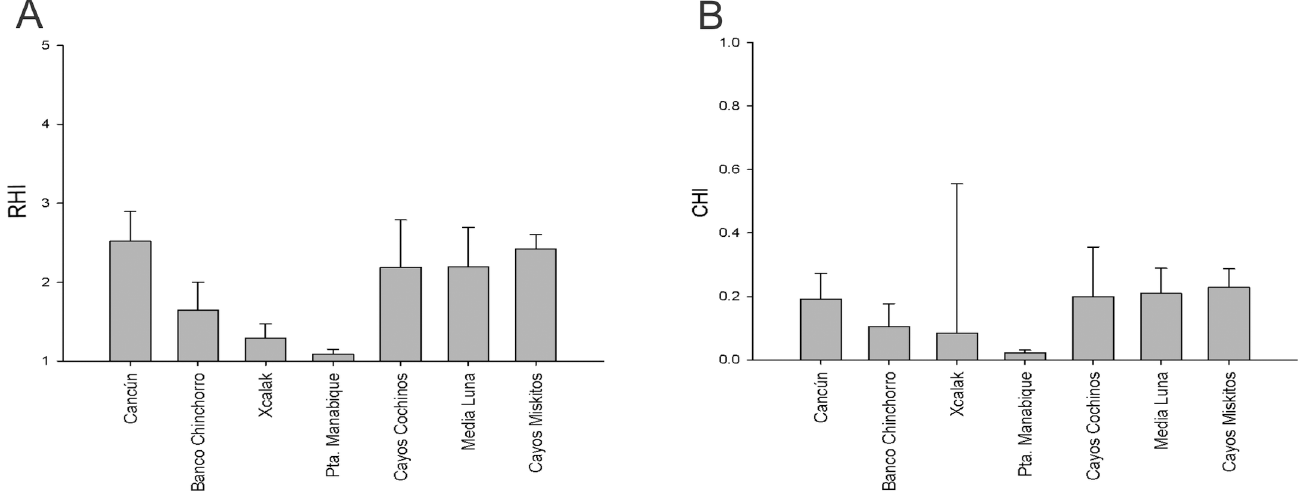
Fig 4. Grade of reef health estimated with the indices RHI and 2D-CHI in each study zone. a) RHI health grade per zone; b) CHI health grade per zone.